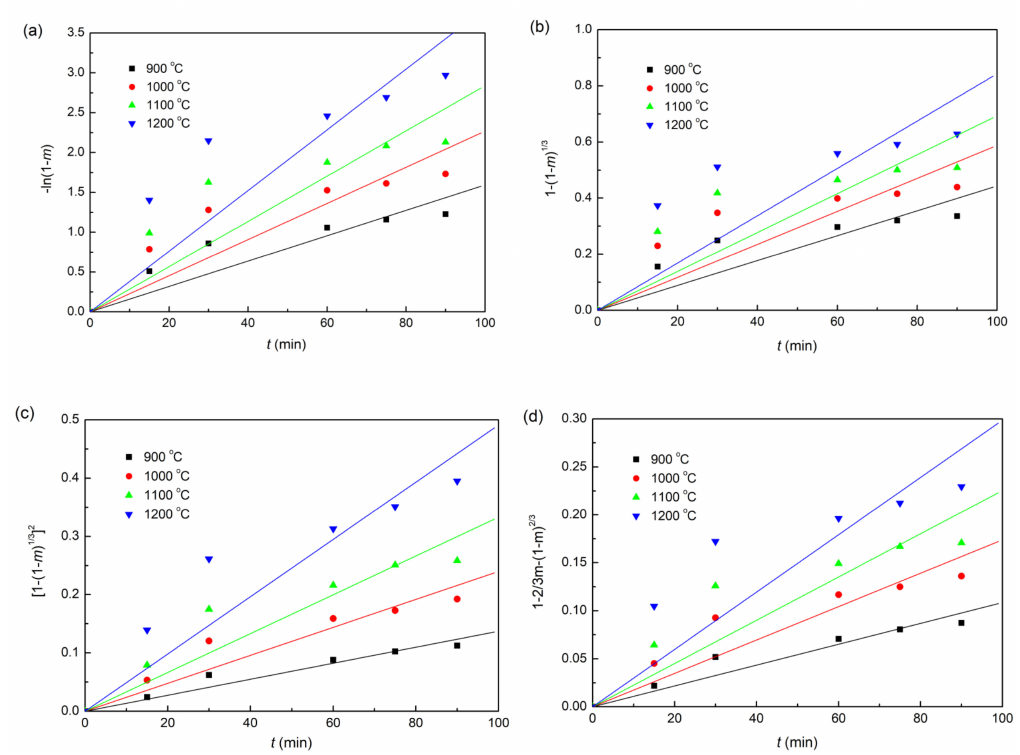
Figure 8. Linearized form plots of kinetic model for the reduction of iron ore in iron ore–biomass composite pellet: